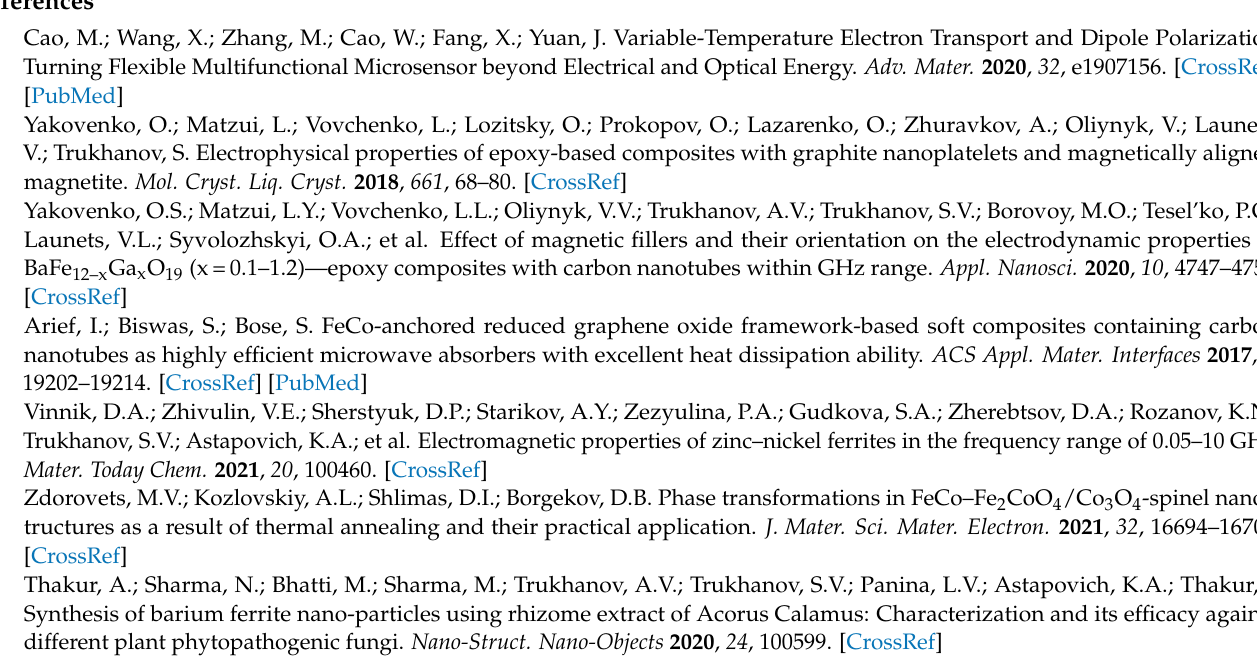
Figure S2: XRD patterns and FTIR spectras of SiO 2 @Fe(OH) 3 and SiO 2 @Fe(OH) 3 -GT, Figure S3: XPS spectra of the SiO 2 @Fe 3 C/Fe@NCNT-GT, Figure S4: SEM image of SiO 2 @Fe 3 C/Fe@NCNT-GT, Figure S5: (a) TEM image, (b) Average diameter of NCNTs and NPs of SiO 2 @Fe 3 C/Fe@NCNT-GT, Figure S6: (a) µ (cid:48) — f curves, (b) µ ”— f curves, and (c) tan δ m — f of SiO 2 @Fe 3 C/Fe@NCNT-GT and SiO 2 @Fe 3 C/Fe@NCNT, Figure S7: Magnetization hysteresis loops of the SiO 2 @Fe 3 C/Fe@NCNT-GT and SiO 2 @Fe 3 C/Fe@NCNT, Figure S8: Cole-Cole semicircles of the (a) SiO 2 @Fe 3 C/Fe@NCNT-GT and (b) SiO 2 @Fe 3 C/Fe@NCNT, Figure S9: The M z — f curves of the (a) SiO 2 @Fe 3 C/Fe@NCNT-GT and (b) SiO 2 @Fe 3 C/Fe@NCNT, Figure S10: R L — f curves of (a) the SiO 2 @Fe 3 C/Fe@NCNT-GT with a filler ratio of 20 wt.% and (b) 30 wt.%, Table S1: Electrical conductivity of absorbing materials, Table S2: EMW absorption properties of some representative